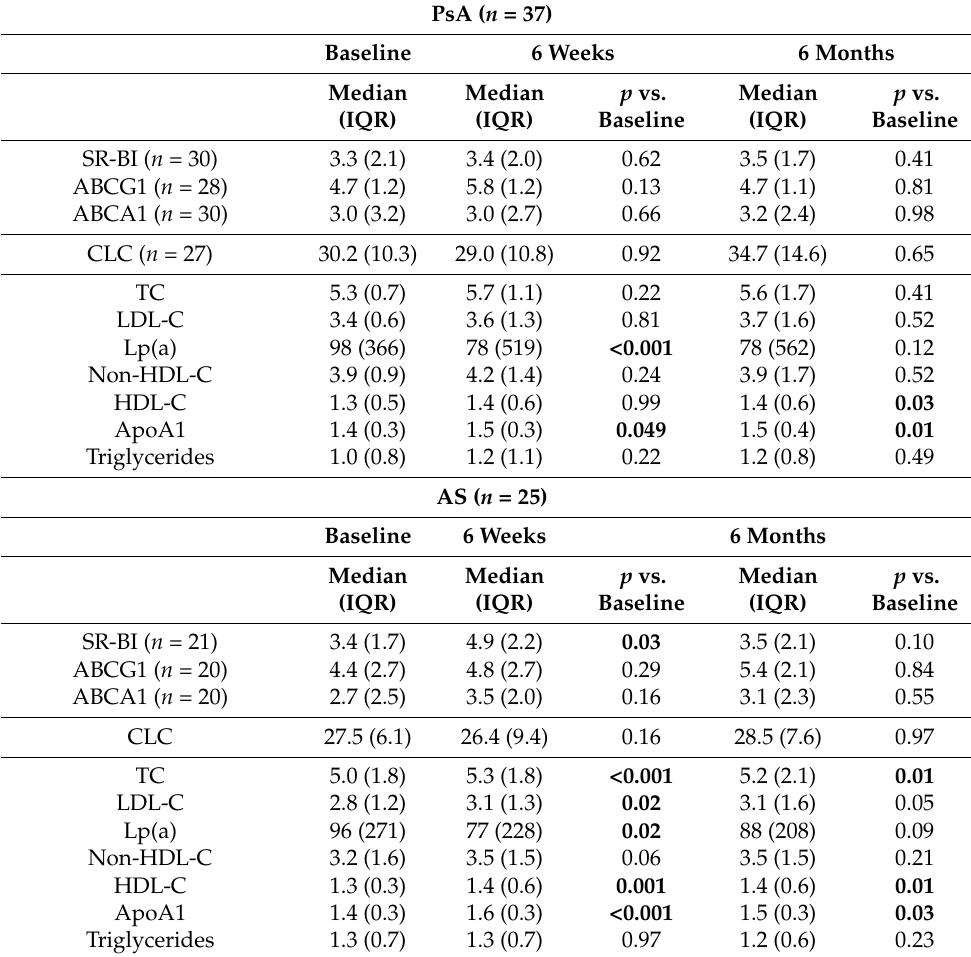
Table 3. Functional lipid parameters and serum lipid levels in PsA and